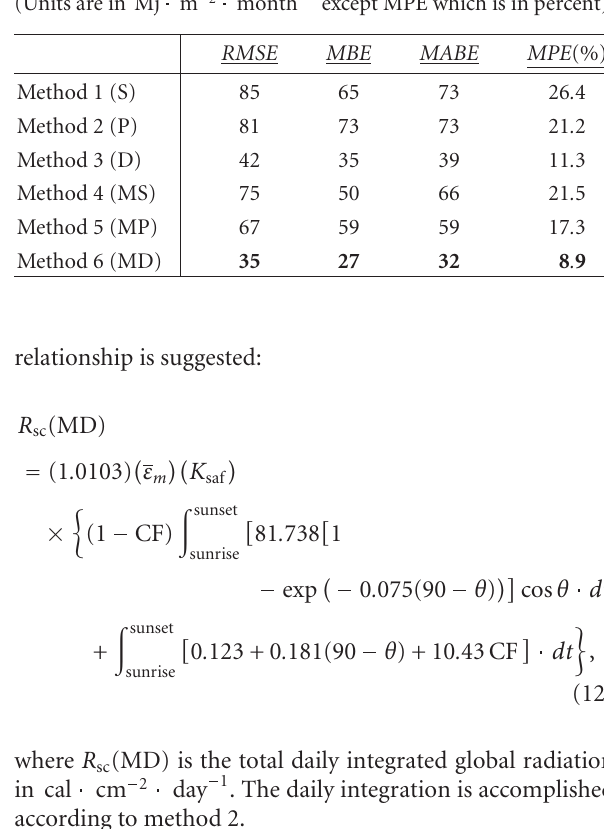
m (cid:3) 2 month (cid:3) 1 except MPE which is in (cid:2) (cid:2)